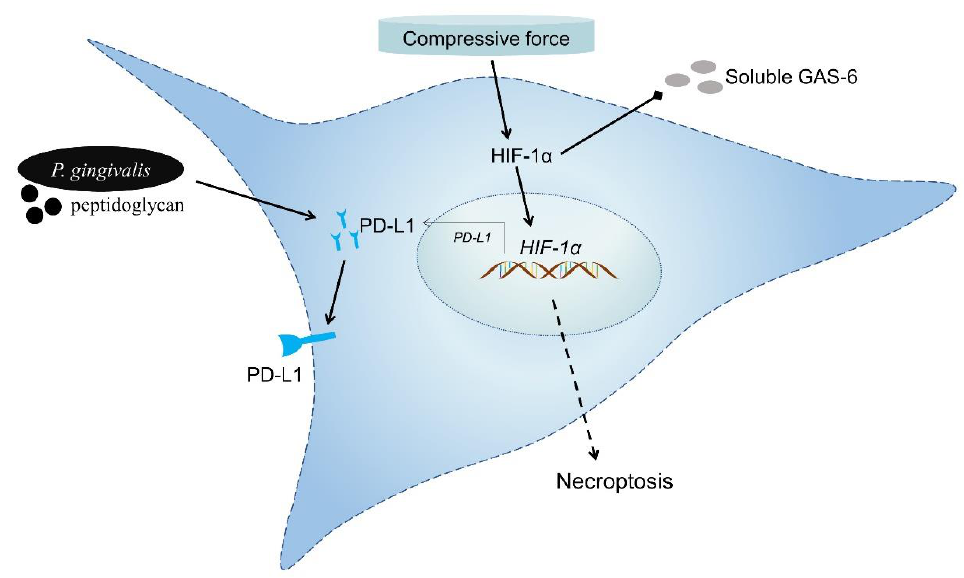
Scheme 1. The scheme depicts the mode of action of HIF- 1α in cementoblasts: P. gingivalis